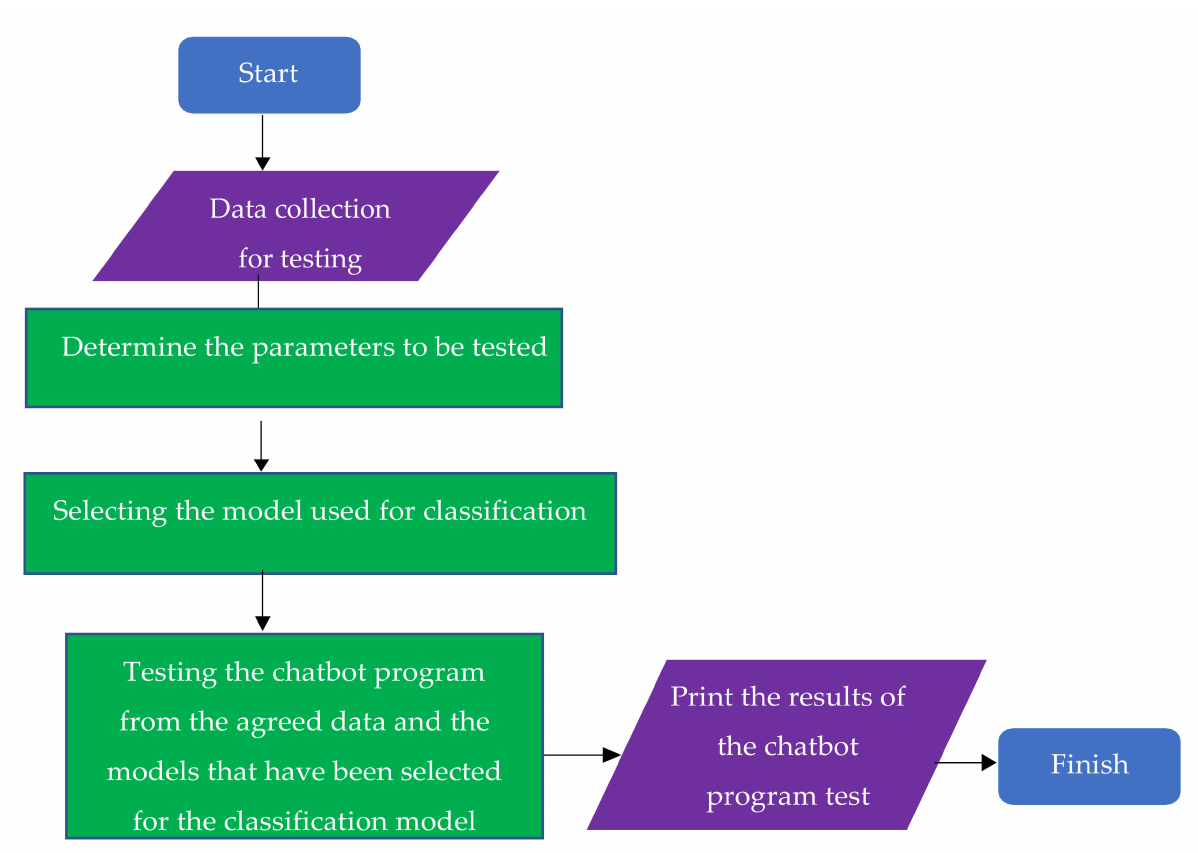
Figure 4. Chatbot programming